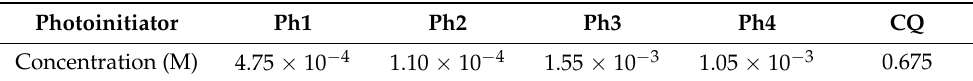
Figure 2. Heatmaps of the polymerization rate ( μ mol s − 1 ) (left) and maximum temperature rise (right) during photoinitiated polymerization of TMPTA; photoinitiating systems consisted of pho- toinitiators: dibenzo[a,c]phenazine (Ph1), benzo[a]phenazine (Ph2), 11 H -indeno[1,2-b]quinoxalin- 11-one (Ph3), 6 H -indolo[2,3-b]quinoxaline (Ph4) and camphorquinone (CQ), and co-initiators: (phe- nylthio)acetic acid (PhTAA), 1-naphthoxyacetic acid (NAA), phenoxyacetic acid (PhAA) and ethyl 4-dimethylaminobenzoate (EDMAB). The tested systems are effective visible light photoinitiators in dental compositions. Their ability to initiate a chain reaction depends on both the type of light absorber (dyes) and the co-initiator (acids). Differences in their structure affect the properties of acids, e.g.,